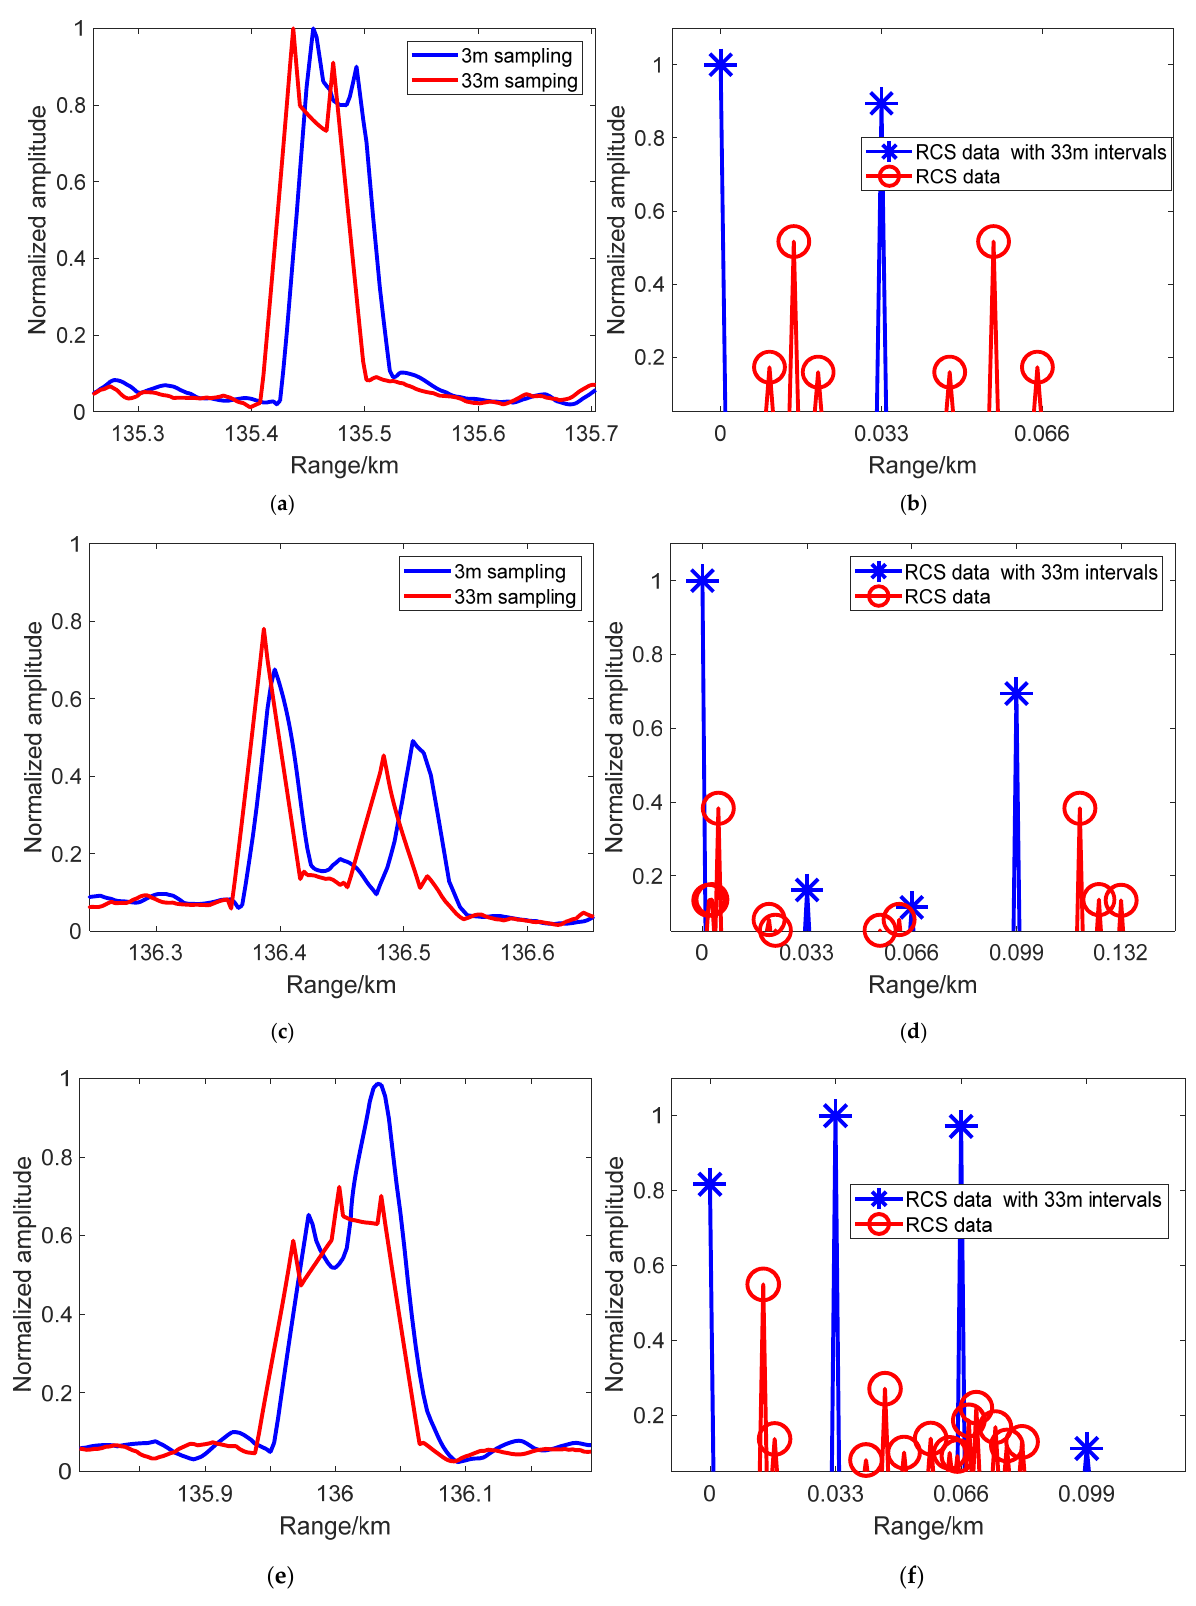
Figure 13. One-dimensional range detection results of 3 ship targets under the detection of satellite 3 with 33-meter echo sampling and 3-meter echo sampling and the corresponding RCS data distribution: ( a ) ship 1 detection result; ( b ) ship 1 RCS data; ( c ) ship 2 detection result; ( d ) ship 2 RCS data; ( e ) ship 3 detection result; ( f ) ship 3 RCS data.